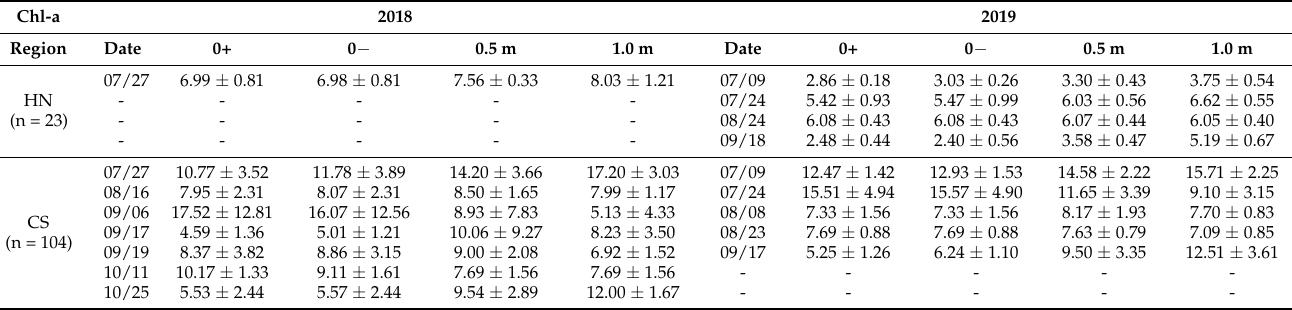
Table A1. Observed Chl-a in HN and CS